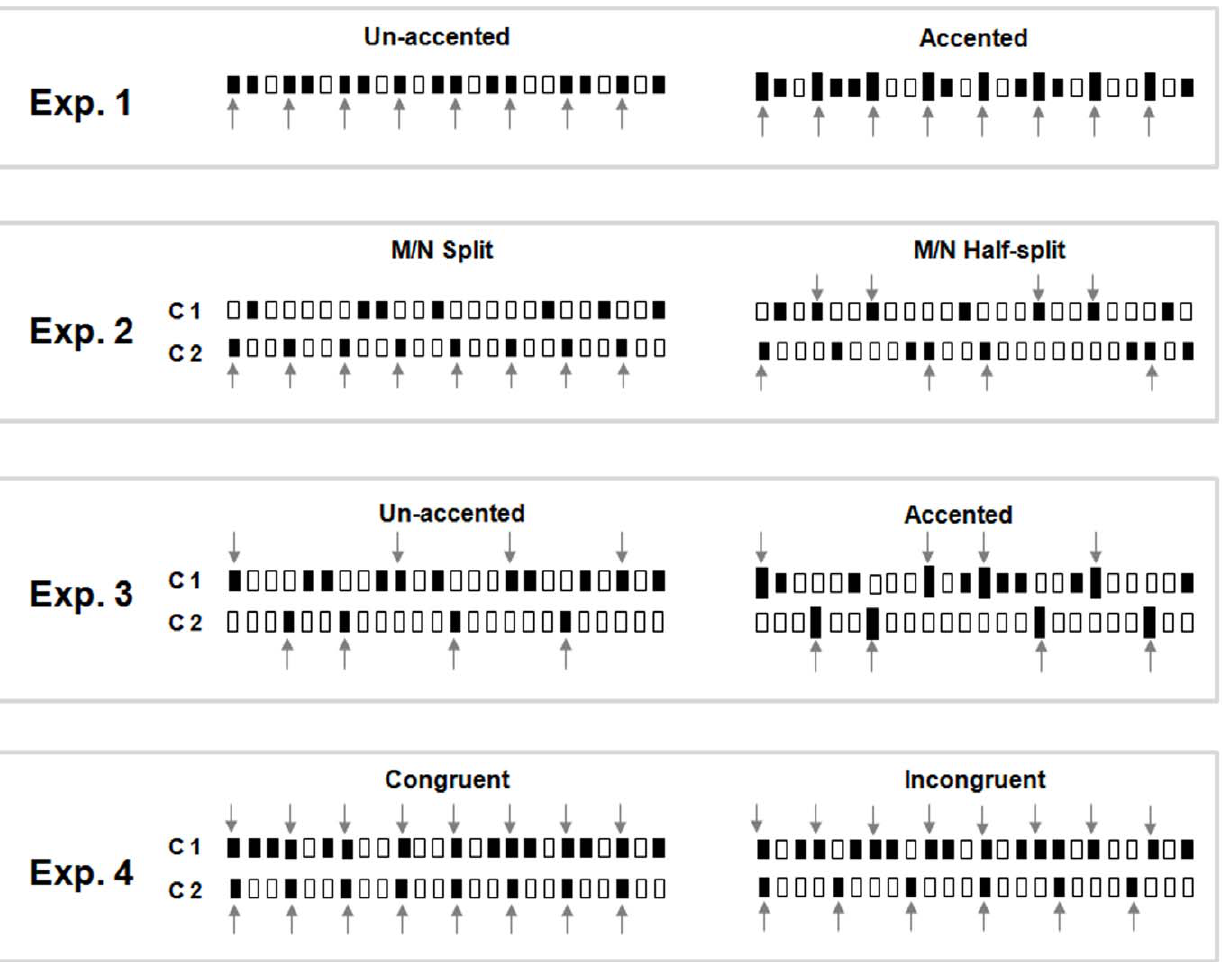
Figure 3. Test trial of Triple sequence examples. Each open bar represents a 500 ms silence. Each dark bar represents a note (pure tone/ sinusoidal vibration) with a duration of 350 ms followed by 150 ms of silence. Larger dark in accented trials represent an amplitude accent, with 20 dB higher amplitude than regular dark notes. Exp. 1: unimodal trial, a whole triple sequence is assigned to either auditory or tactile modality. Ex. 2 and 3: bimodal trials, dark bars in channel 1 and channel 2 together compose a whole triple sequence. Exp. 4: bimodal trials, channel 1 contain a whole triple sequence, channel 2 contain additional Triple (Congruent) or Duple (Incongruent) M notes. For Exp. 2, 3, and 4, channel 1 notes sent to one modality and channel 2 notes sent to another modality. Channel 1 and 2 notes are assigned to either auditory and tactile modalities, or tactile and auditory modalities, respectively. (Figure 3). Experiment 1 has four test conditions (Table 1). Each test condition was tested in 16 trials for triple- and duple- tending sequences, respectively, with a total of 128 trials. Results of Experiment 1 are shown in Figure 4.